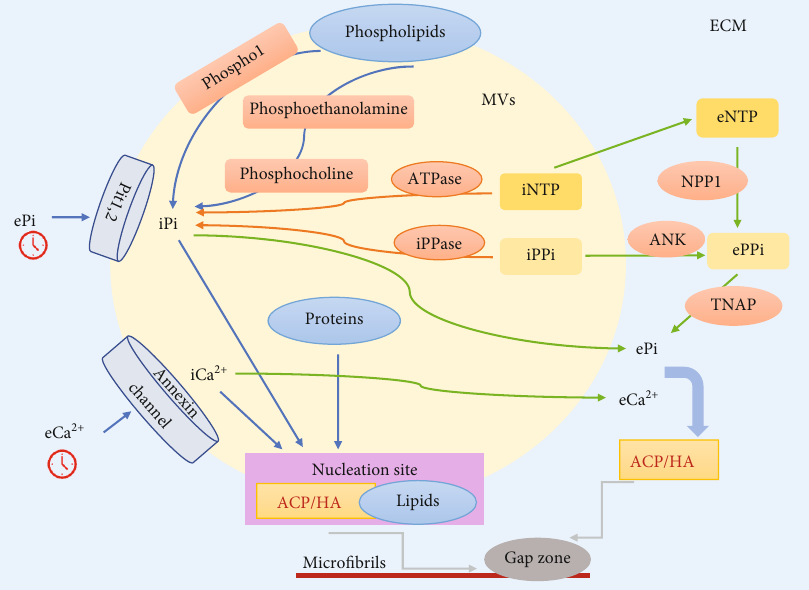
Figure 2: The two patterns of ACP/HA formation by MVs. For one pattern, iNTP transforms into iPi through ATPase, and iPPi transforms into iPi by iPPase. Then, iPPi is secreted out of MVs by ANK, and iNTP transports into ECM as ePPi. And iNTP could transform into iPPi by NPP1. Extracellular PPi and iNTP hydrolyze to Pi via TNAP [21]. In the meantime, intracellular Ca 2+ and iPi translate into the matrix. ePi and eCa 2+ synthesize HA or ACP. On the other hand, PHOSPHO1 activates the formation of apatite crystals by hydrolyzing phospholipid and collaborating with phosphoethanolamine and phosphocholine [23]. The annexin channels allow a mass of Ca 2+ to enter into MVs [24]. It is possible that lipids in the membranes of MVs are nucleation sites, and Ca 2+ , Pi, and some other proteins in MVs constitute speci fi c structures, where HA or ACP could crystallize [25]. MVs: matrix vesicles; iNTP: intracellular